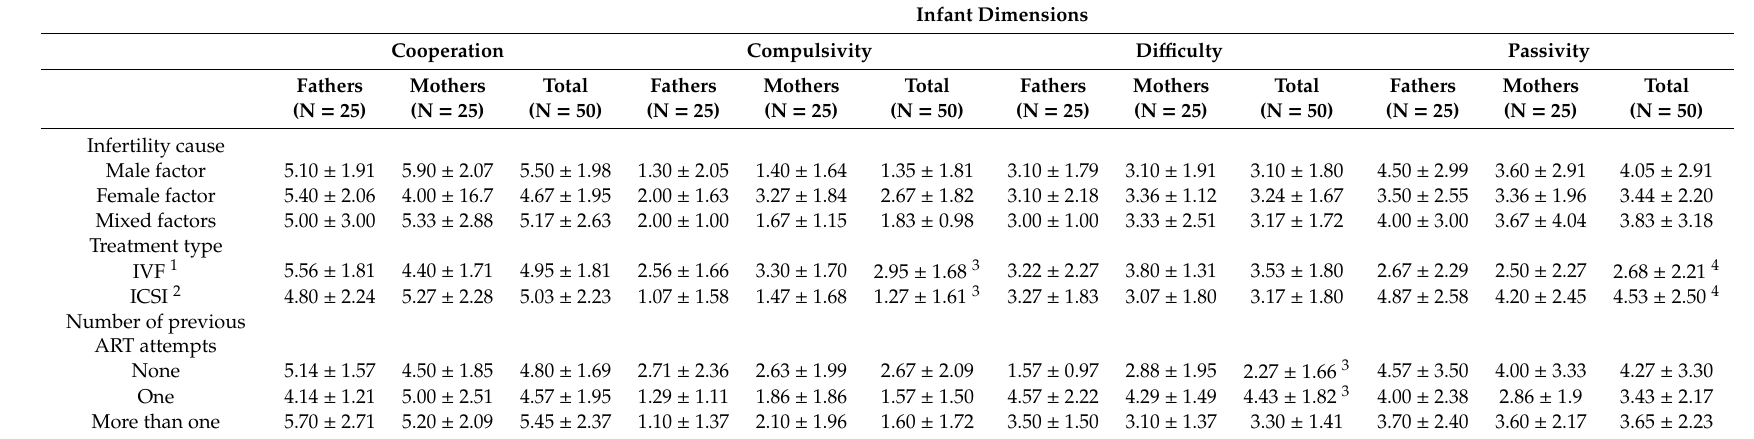
Table 7. Interactive styles (CARE-Index dimensions) in ART infants by infertility cause, treatment type, and number of previous ART attempts. Infant Dimensions Cooperation Compulsivity Di ffi culty Passivity Fathers Mothers Total Fathers Mothers Total Fathers Mothers Total Fathers Mothers Total (N = 25) (N = 25) (N = 50) (N = 25) (N = 25) (N = 50) (N = 25) (N = 25) (N = 50) (N = 25) (N = 25) (N =